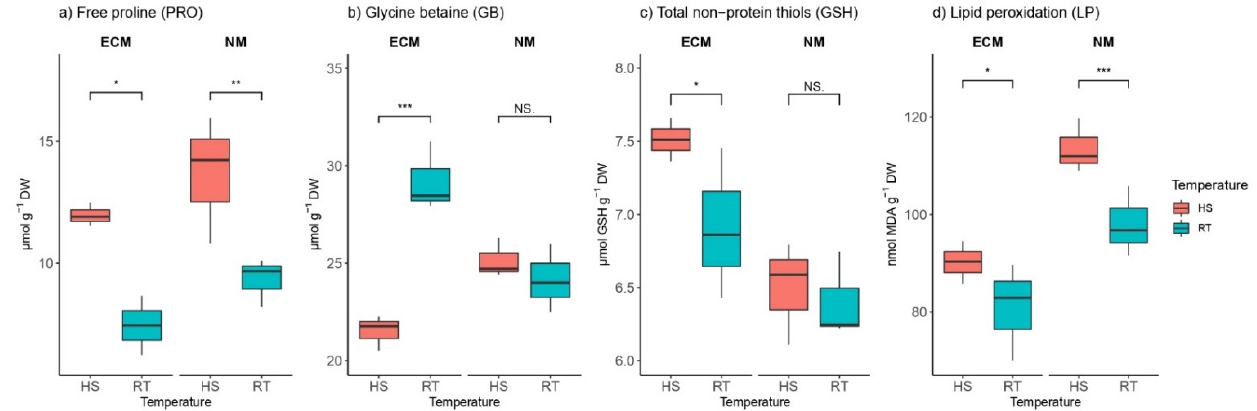
Figure 3. Changes in ( a ) proline (PRO, mmol g − 1 DW), ( b ) glycine betaine (GB, mmol g − 1 DW), ( c ) total non-protein thiols (mmol GSH g − 1 DW), and ( d ) lipid peroxidation intensity (nmol MDA g −